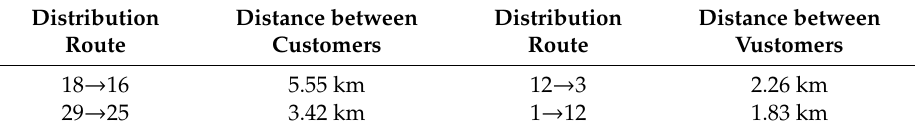
Table 4. Examples of order combination under multi-objective optimization.